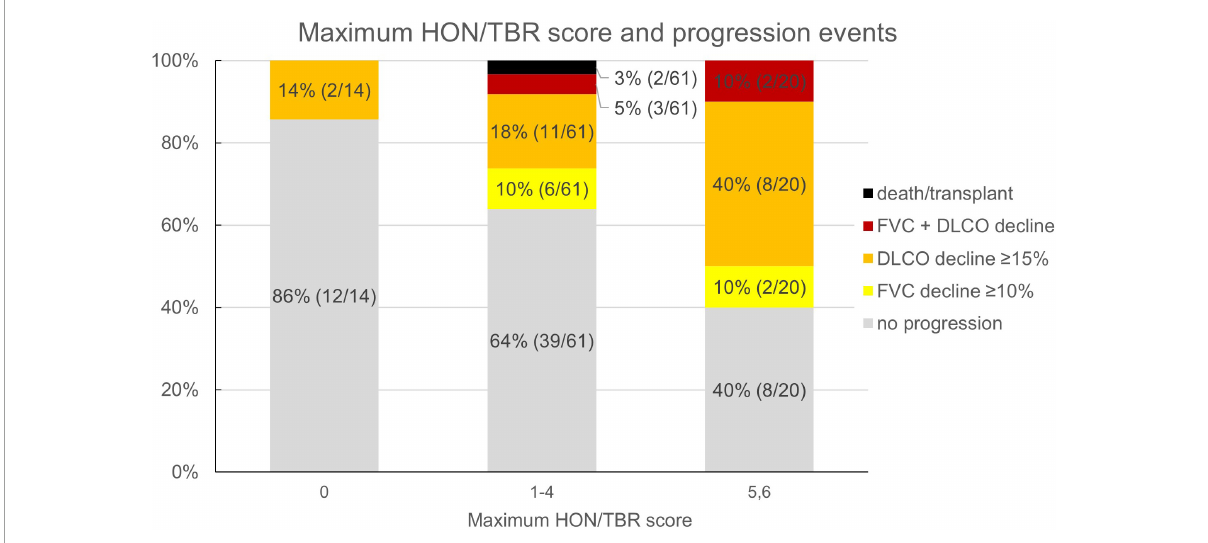
FIGURE2 Honeycombing/traction bronchiectasis score and fraction (number) of progression events. HON/TBR, honeycombing/traction bronchiectasis; FVC, forced vital capacity; DLCO, diffusion capacity for carbon